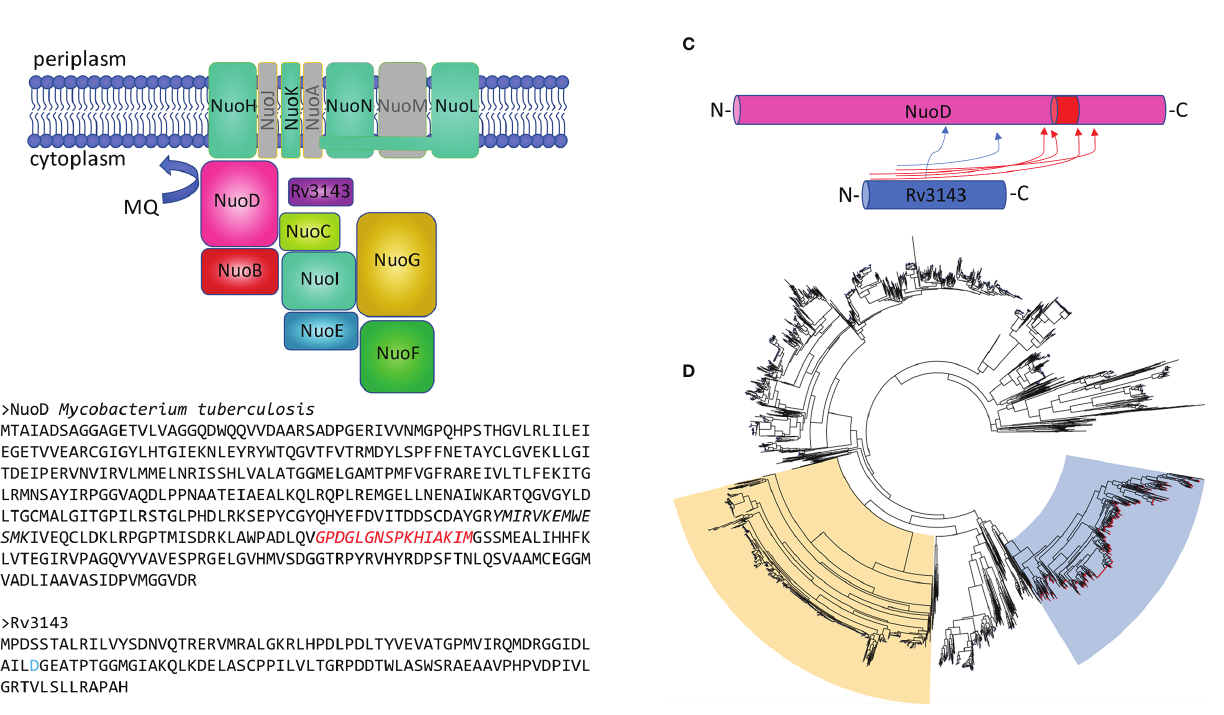
FIGURE 1 | The orphan response regulator Rv3143 is a component of the NuoA – N complex in actinobacteria. (A) Graphical summary of the interaction network of Rv3143 with NADH dehydrogenase complex I in Mycobacterium tuberculosis based on a single-step af fi nity puri fi cation method coupled with mass spectrometry. Nuo components that were not copuri fi ed with eGFP-Rv3143 used as bait were grayed out (the fi gure layout was modi fi ed from Schut et al. [(Schut et al., 2016)]. (B) Sequences of M. tuberculosis NuoD and Rv3143 are shown. Putative, conserved phosphorylation site (D, aspartic acid) is marked in blue on the Rv3143 sequence. The amino acid insertion sequence (marked in red) found in actinobacterial NuoD proteins may be involved in mediating the interaction between NuoD and Rv3143, as indicated by mass spectrometry BS3 crosslinking analysis performed with Kojak software. Crosslinks with Kojak scores higher than 0.5 are shown in the rudimentary cartoon fi gure (C) . Insertion of the amino acid stretch depicted in panel B is common in actinobacteria, and its presence correlates with the co- occurrence of Rv3143 orthologs in these bacteria. The phylogenetic tree is shown (D) , where the blue background indicates the NuoD cluster for which genomic co- occurrence of Rv3143 orthologs is evident (red nodes on each tree leaf). The phylogenetic cluster for NuoCD and NuoBCD chimeric proteins, common in proteobacteria, is indicated with moccasin color for